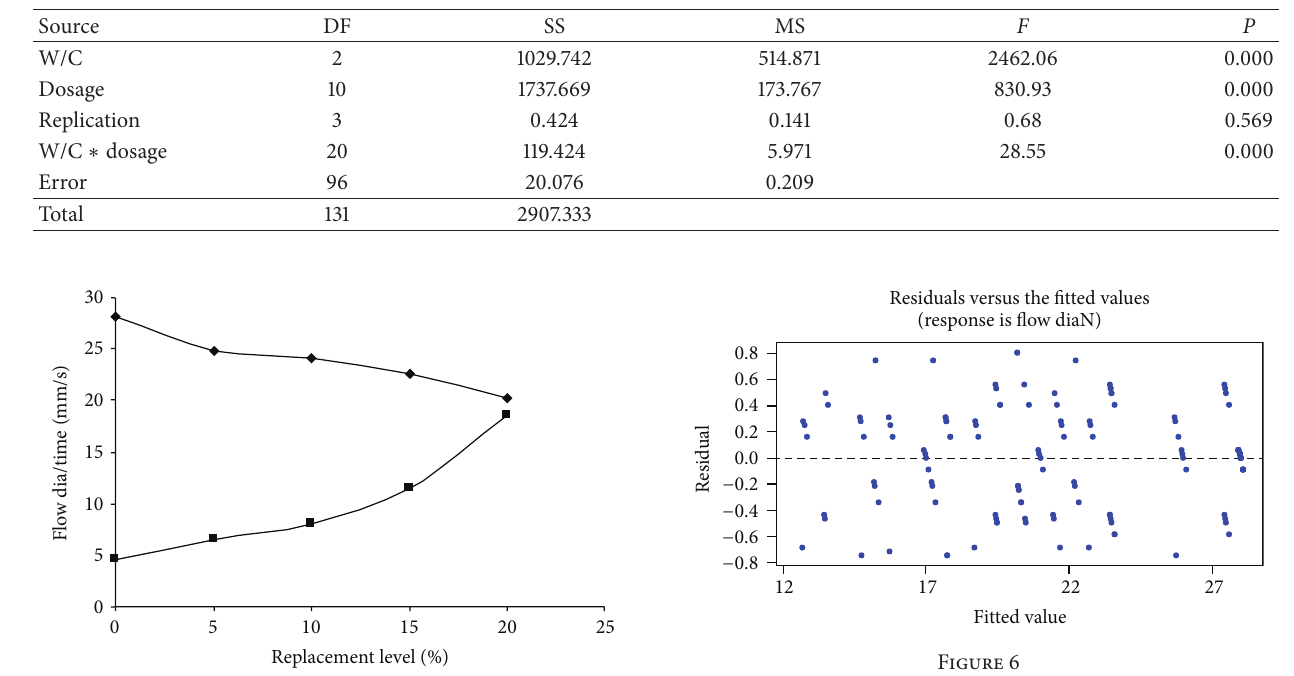
Table 8: Balanced ANOVA on fluidity results.